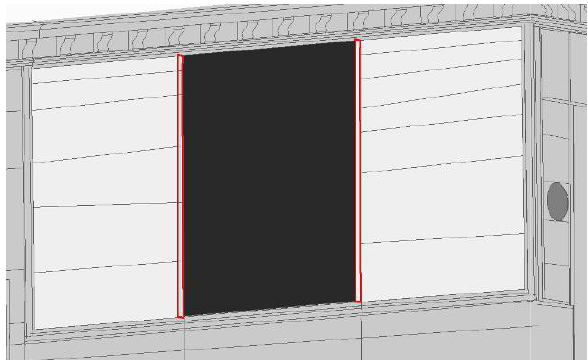
Figure 2: detail of the modelling of the wall and wallcovering. The dark grey represents the wall, the lighter grey the wallcovering. The red sections are extracted from point cloud and used for swept